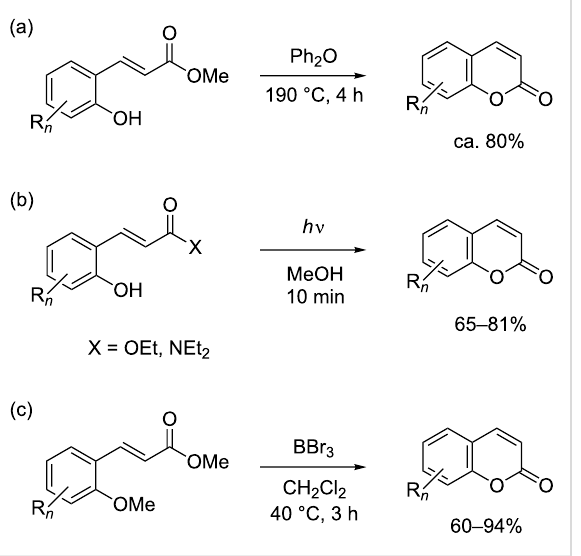
Scheme 1: Conditions for the cyclization of 2’-hydroxycinnamate and related precursors to coumarins. (a) Thermal cyclization [16]. (b) Photochemical isomerization/cyclization [17]. (c) Lewis acid induced demethylation/cyclization [18].